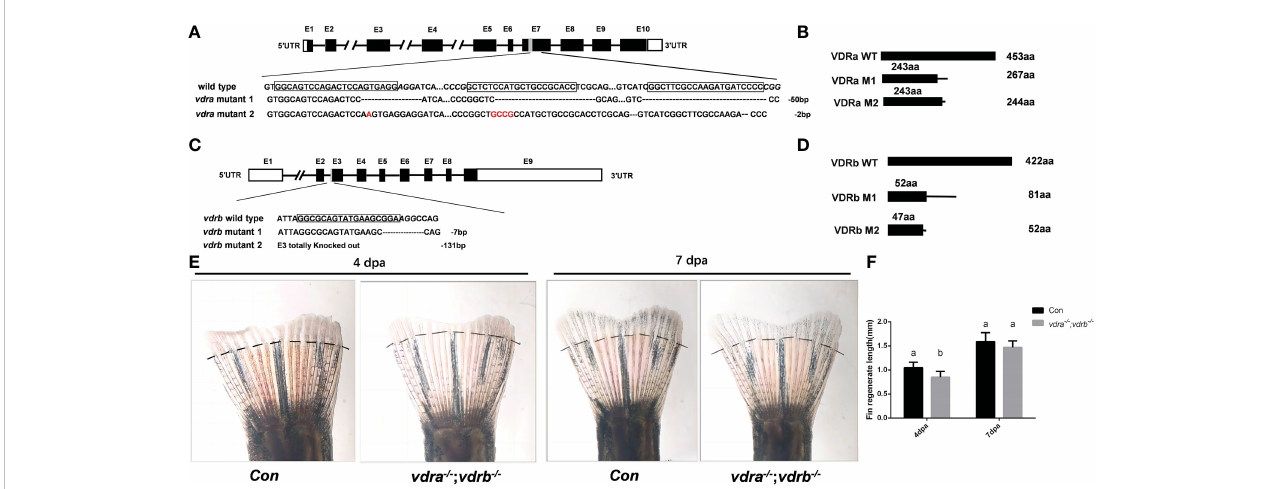
FIGURE 1 Generation of zebra fi sh vdra - and vdrb – de fi cient using CRISPR/Cas9 technique. (A) Targeted depletion of the vdra gene; The CRISPR/Cas9 target site was located in exon 7. Two genotypes, 50-bp deletion and 2-bp deletion, were used to establish the vdra knockout line (highlighted in red); (B) The diagram shows the predicted VDRa protein from wild-type, M1, and M2 zebra fi sh. M1 consisted of 243 amino acids identical to WT (green) and 24 miscoding amino acids (black); M2 consisted of 243 amino acids identical to WT and one miscoding amino acid (black); (C) Targeted depletion of the vdrb gene; The CRISPR/Cas9 target site was located in exon 3. Two genotypes, 7-bp deletion and 131-bp deletion, were used to establish the vdrb knockout line (highlighted in red); (D) . The diagram shows the predicted VDRb protein from wild-type, M1, and M2 zebra fi sh. M1 consisted of 52 amino acids identical to WT (green) and 29 miscoding amino acids (black); M2 consisted of only 47 amino acids identical to WT and fi ve miscoding amino acids (black). (E) Zebra fi sh(100dpf) caudal fi n regeneration at 4 and 7days post amputation. Dashed lines indicated approximate amputation planes. (F) . Statistical analysis of the regeneration length. Six fi sh were used in each group. The bars with different letters indicated signi fi cant